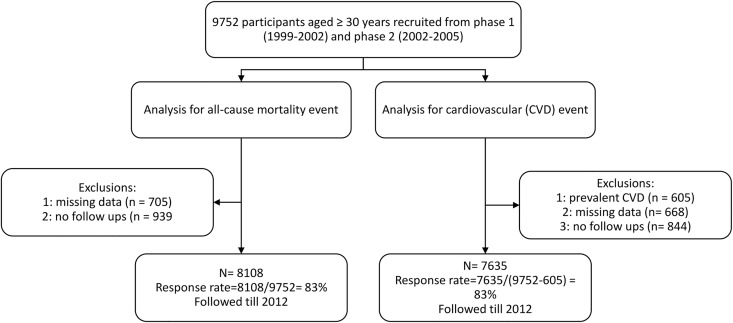
Study population.